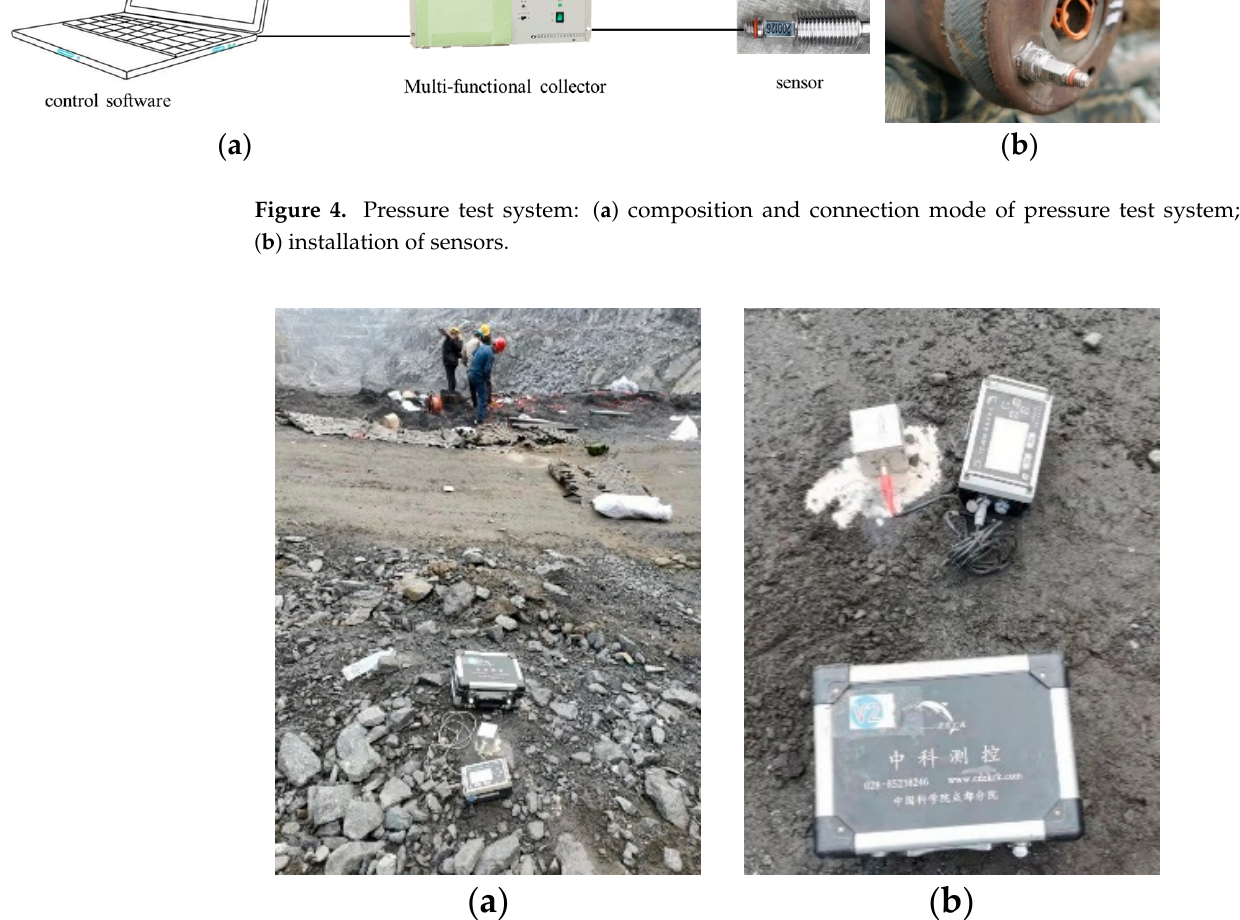
( b ) Figure 6. Fragment-size distribution: ( a ) explosive; ( b ) L-CDRB.